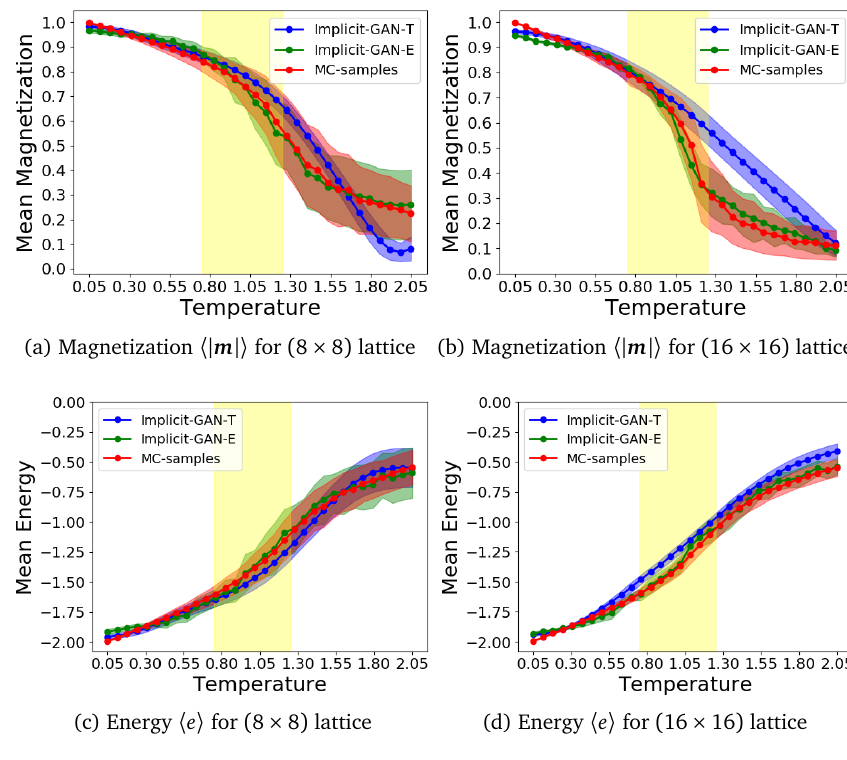
Figure 5: Same as Fig. 4, but no training data was provided in the region T ∈ [ 0.75,1.25 ] (highlighted in yellow) in the vicinity of the